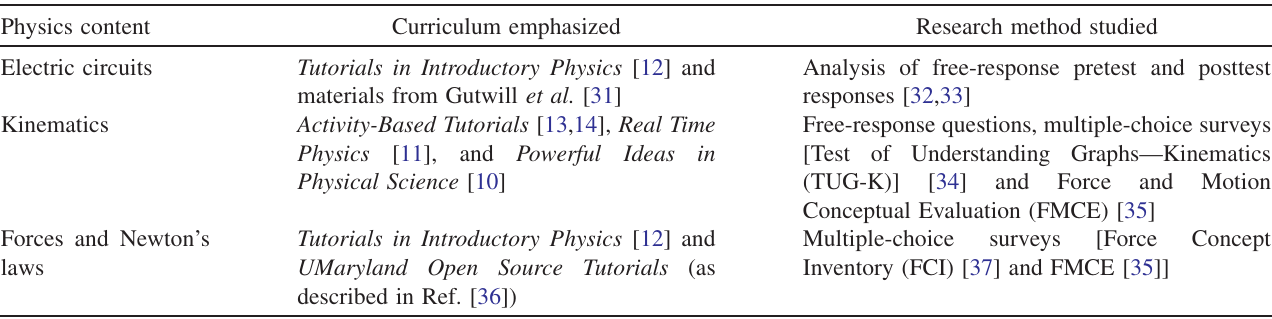
TABLE I. Course I instructional units.